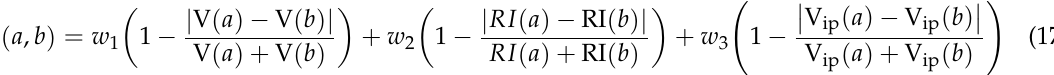
Figure 13. The number of matched particles versus threshold P . 3. Results and Discussion The unique possibility to obtain a 3D image of the proppant pack under stress using the experimental technique described above allows modeling of mechanical (stresses redistribution, elastic, and plastic deformation), chemical (acidizing and chemical precipitation), and hydrodynamic